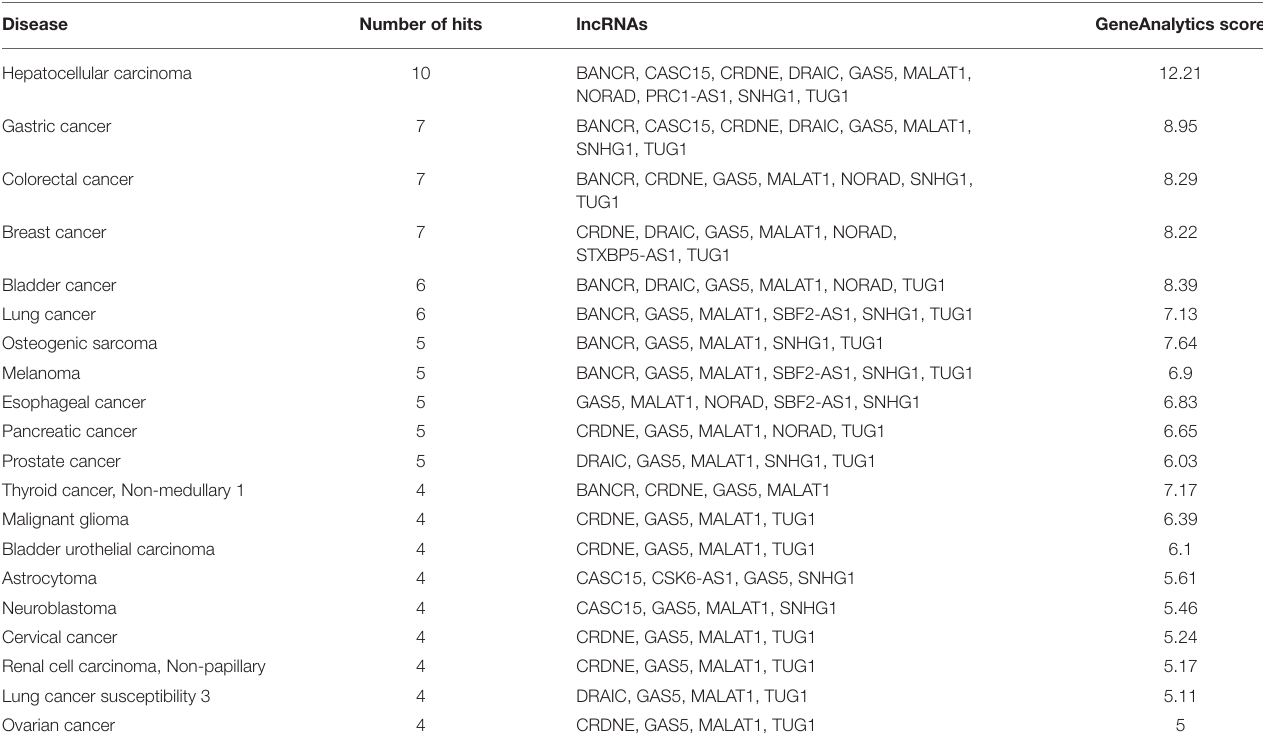
TABLE 5 | Diseases associated with identified lncRNAs in COVID-19 cytokine storm. Disease Number of hits